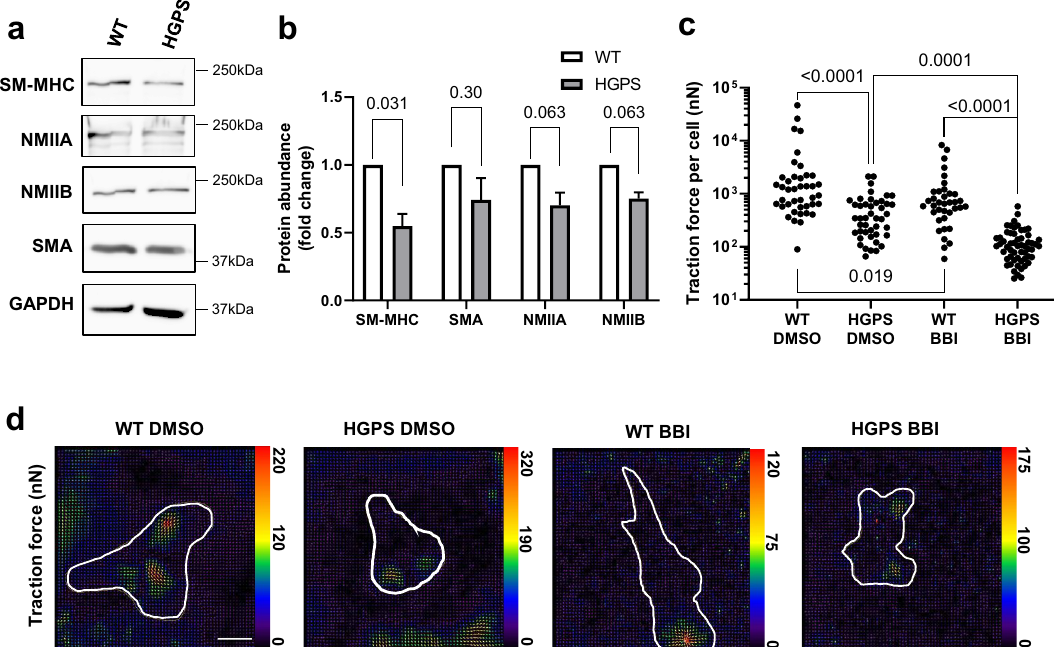
Figure 3. Decreased myosin abundance and traction force in isolated HGPS aortic vascular smooth muscle cells. ( a ) Representative images of cytosolic lysates from cultured SMCs immunoblotted for SM-MHC, non-muscle myosin II A and B (NMIIA and NMIIB, respectively), and SMA. GAPDH is shown as the loading control. Black boxes around the immunoblots indicate cropping for removal of extraneous space. Unprocessed blots are shown in Fig. S1. Blots were stripped and re-probed when evaluating the abundance of multiple myosins and SMA. ( b ) Quantification of immunoblotting results normalized for loading and plotted relative to the WT control. Results show mean ± SE (n = 5–7). Significance was determined by Wilcoxon signed rank test. ( c ) Cultured SMCs were incubated on polyacrylamide hydrogels for 24 h. Cells were treated with vehicle (DMSO) or 15 µM Blebbistatin (BBI) for 30 min prior to traction force analysis. Total traction force plots (n = 37–57 cells) are shown in panel c, and each dot represents the total traction force of a single cell. Significance was determined by Mann–Whitney tests, and results are displayed as scatter plots. ( d ) Representative traction force images of cells analyzed in panel c. Cells areas are outlined in white, and traction force scale bars (in nanonewtons) are displayed to the right of each respective image. Optical scale bar = 50